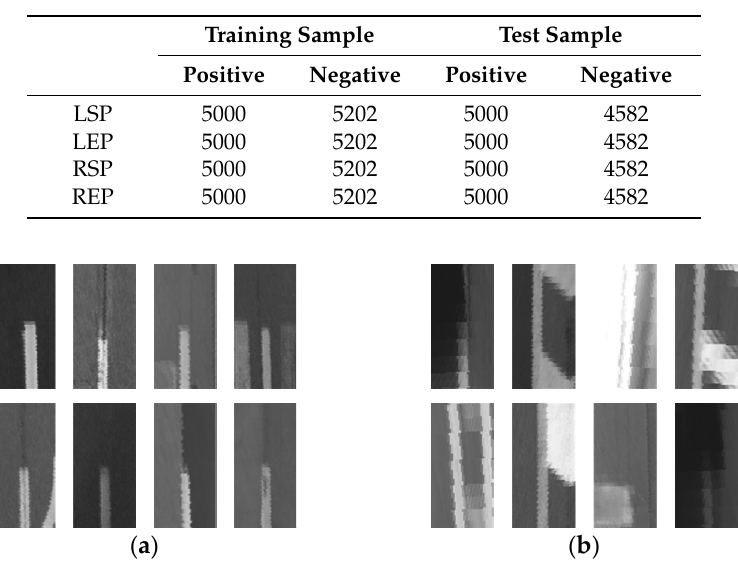
Figure 12. Sample images, ( a ) positive samples; ( b ) negative samples.